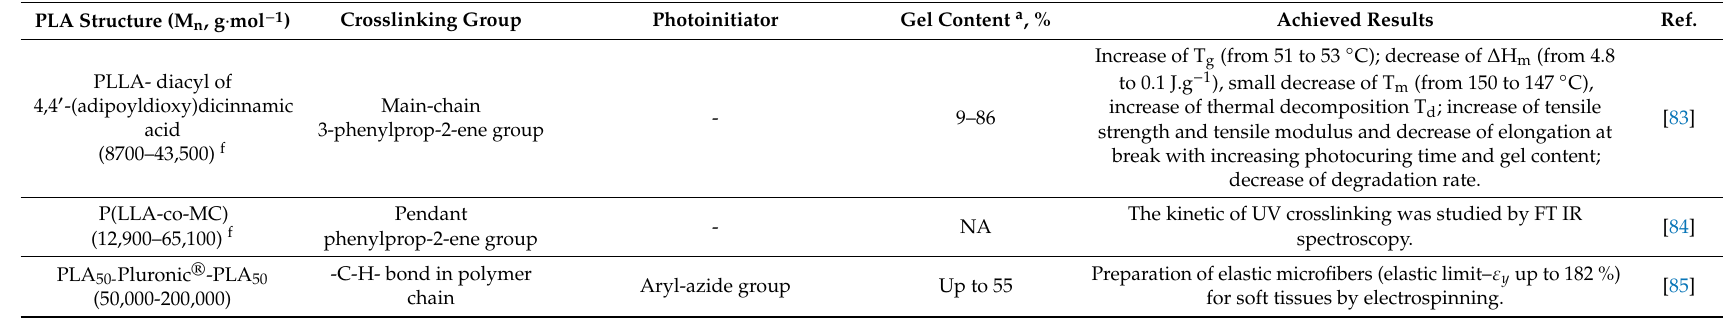
break with increasing photocuring time and gel content; decrease of degradation